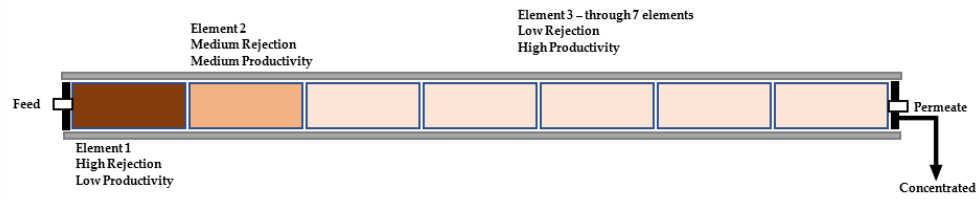
Figure 5. Internal staged RO system, source [50,51].